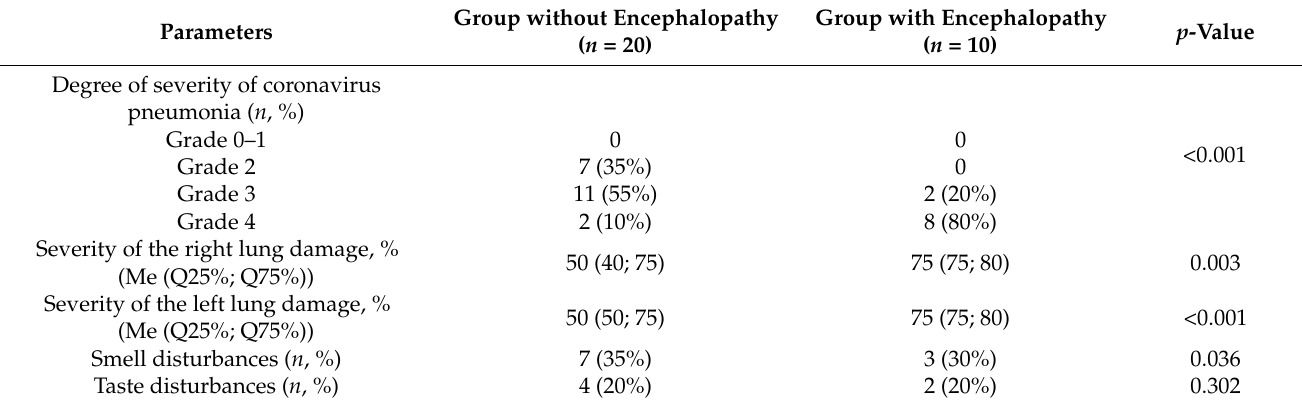
Table 2. The clinical features of coronavirus pneumonia in the studied